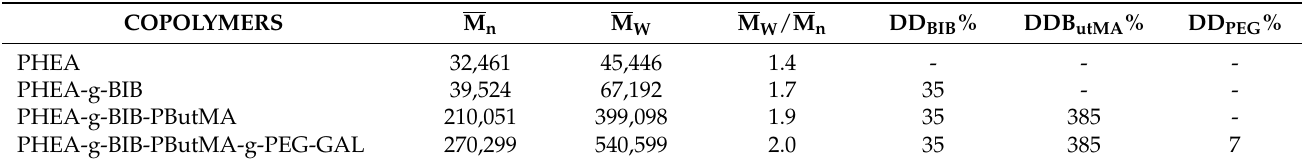
Table 1. Values of weight-average molar weight (Mw) and polydispersity (Mw/Mn) determined